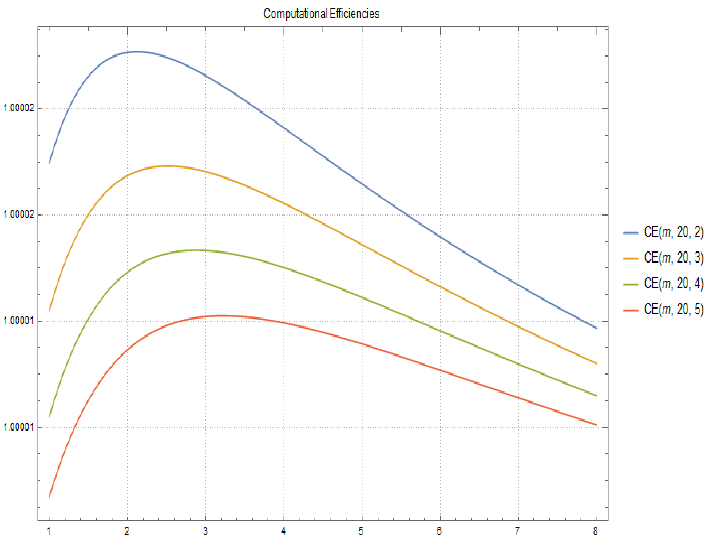
Figure 4. Computational Efficiencies for q = 20 and different values of p and m